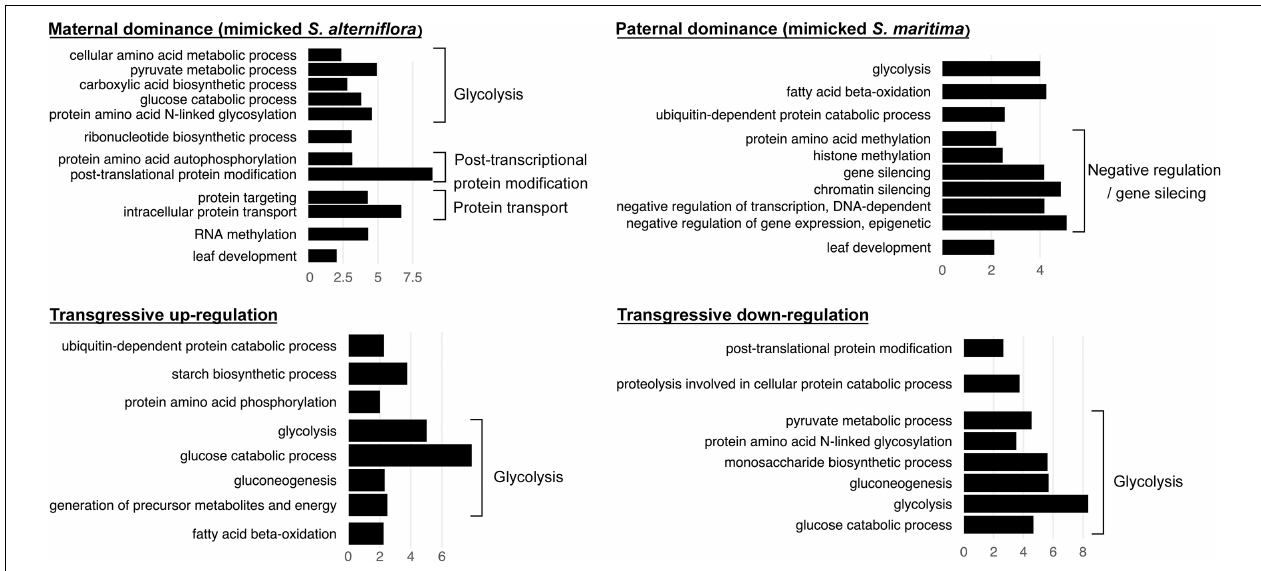
FIGURE 5 | Bar graph of the most enriched GO-terms (biological process) corresponding to genes found DE compared to the MPV and with the same expression patterns in both F1 hybrids S. × townsendii and S. × neyrautii (e.g., bar graph of maternal dominance represents the enriched functions of the 3,045 genes found under maternal dominance in S. × townsendii and in S. neyrautii ). GO-terms were grouped according to their metabolic pathway affiliation. X -axis corresponds to the negative logarithm of adjusted p -value.